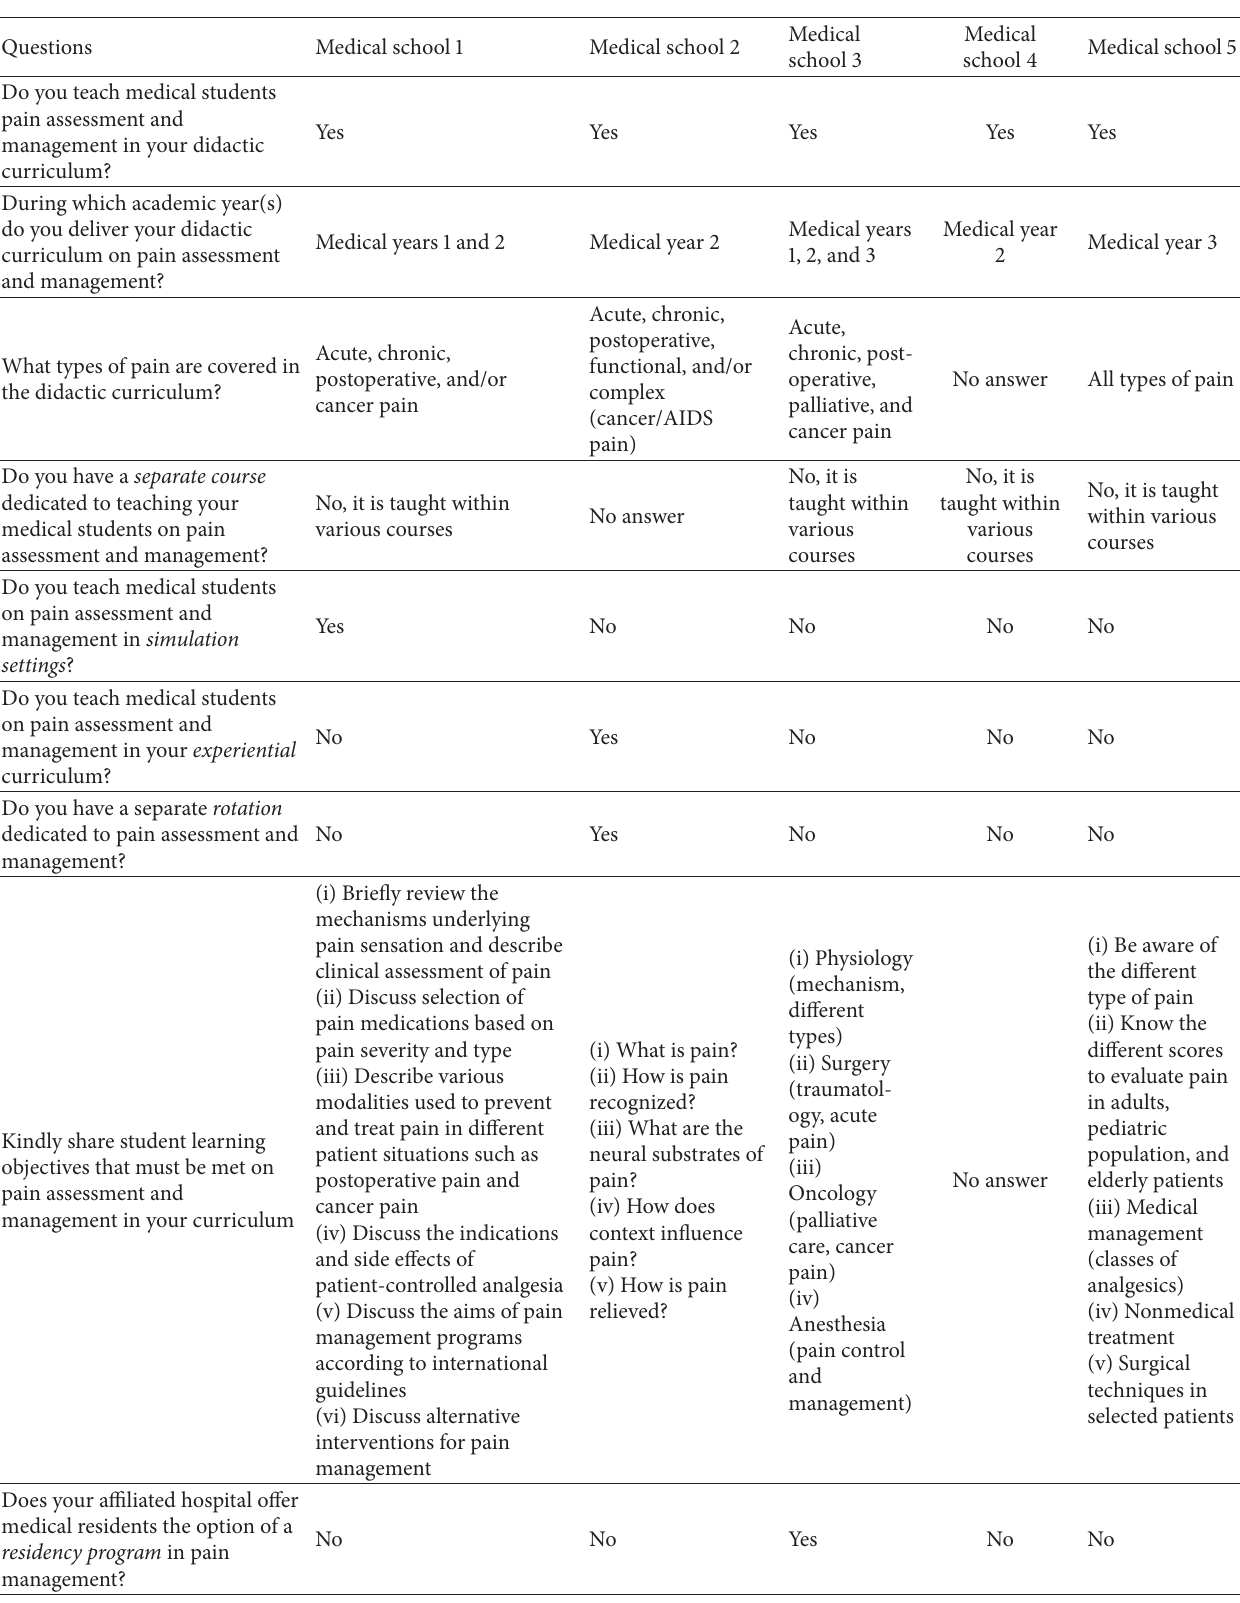
Table 5: Pain education in Lebanese medical schools